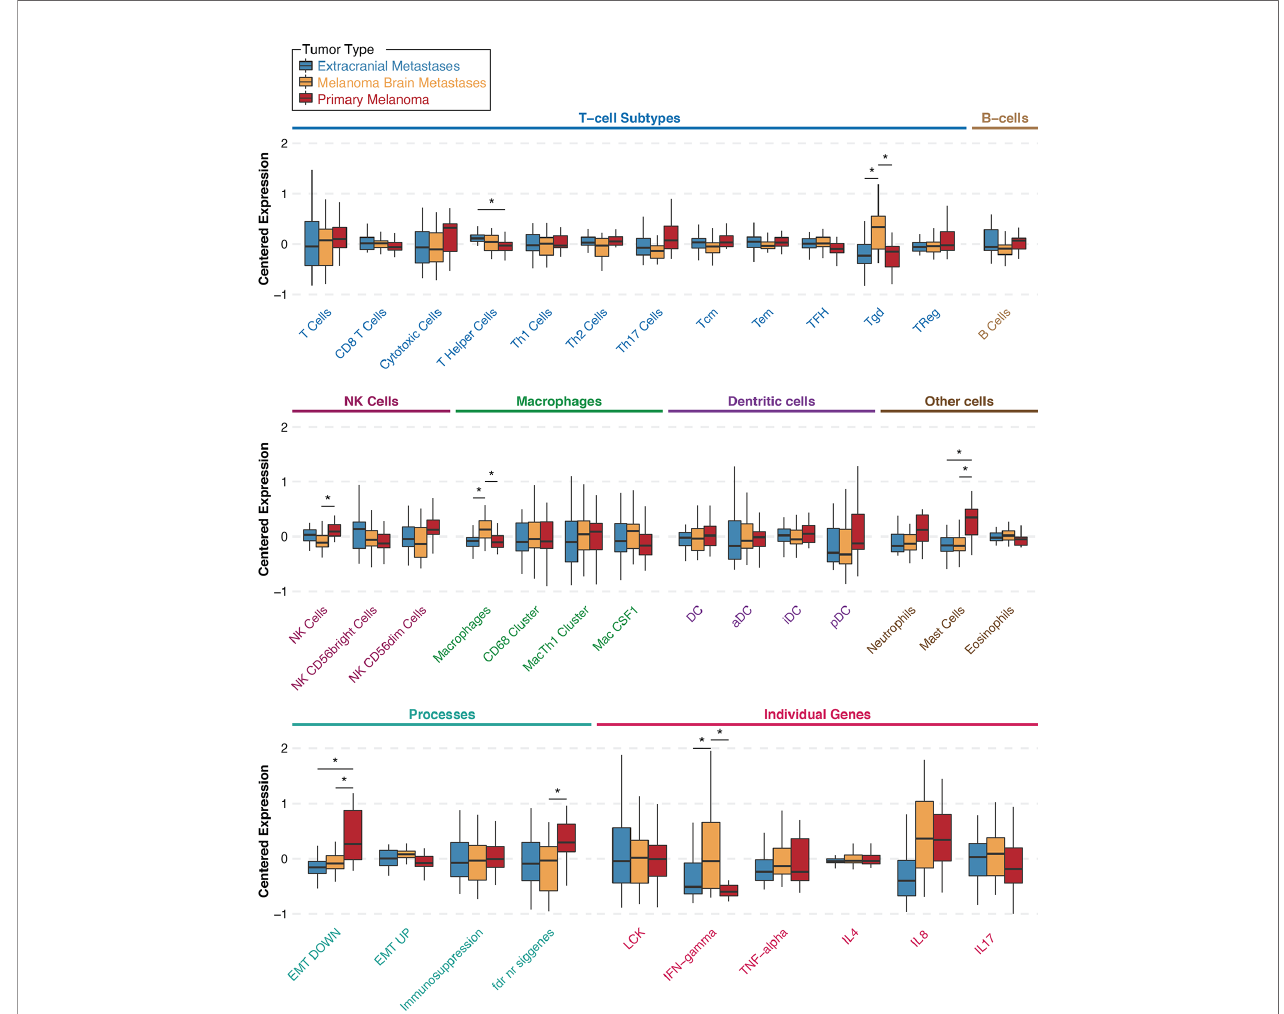
FIGURE 2 | Gene signature scores for extracranial metastases ( blue ), melanoma brain metastases ( orange ), and primary melanoma ( red ) samples from the University of Pittsburgh Medical Center craniotomy cohort. Results are shown as boxplots with median and 95% con fi dence intervals for each signature and tumor type. Asterisks indicate two-way comparisons that are statistically signi fi cant at a nominal p -value <0.05. Abbreviations: Th, T helper; Tcm, central memory T cells; Tem, effector memory T cells; TFH, follicular helper T cells; Tgd, gd T cells; TReg, regulatory T cells; NK, natural killer cells; Mac, macrophages; DC, dendritic cells; aDC, activated DCs; iDC, immature DCs; pDC, plasmacytoid DCs; EMT, epithelial-to-mesenchymal transition; LCK, lymphocyte-speci fi c protein tyrosine kinase; IFN, interferon; TNF, tumor-necrosis factor; IL,